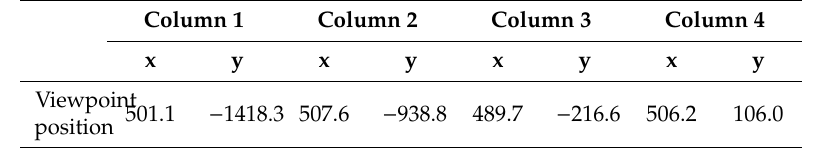
Figure 17. Quantitative evaluation of visual quality: ( a – d ) Method I. ( e – h ) Method II. ( i – l ) Our method. Table 2. Viewpoint positions in Figure 17: the side length of each height di ff erence map in Figure 17 is 1024 (Column 1 corresponds with the first column in Figure 17 and Column 2 corresponds with the second column in Figure 17 and so on).